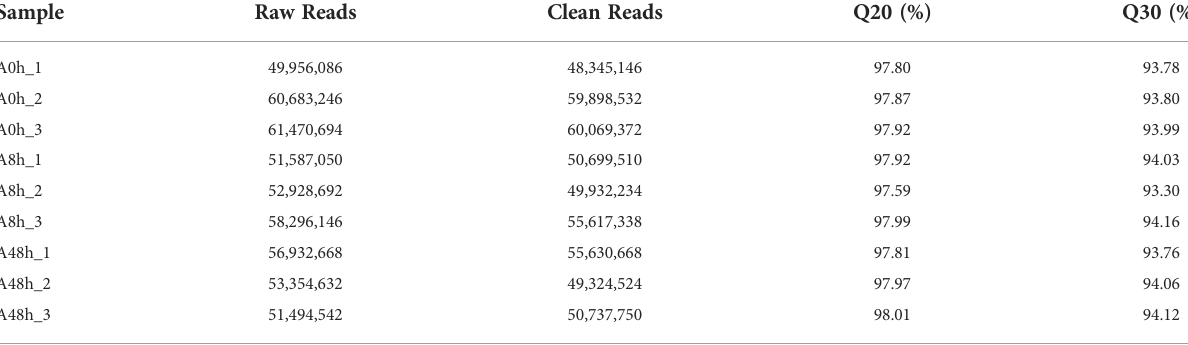
TABLE 2 Summary of transcriptome data